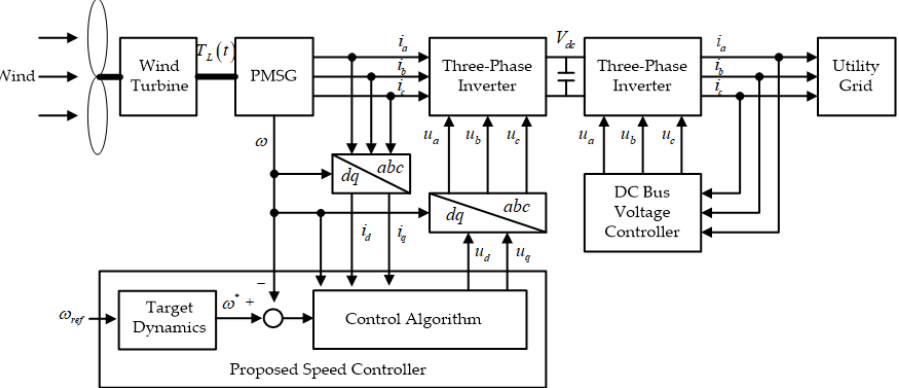
Figure 3. Wind power generation system